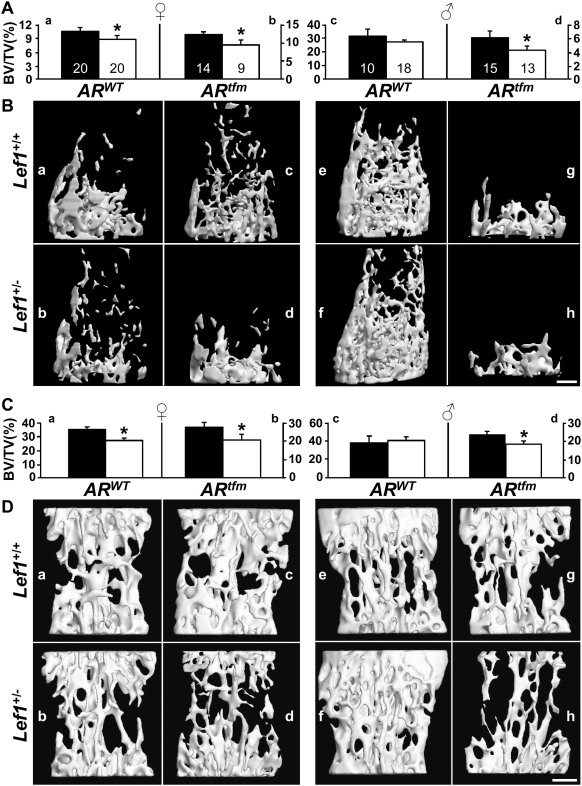
Androgen signaling protects against Lef1 haploinsufficiency-induced low bone mass.μCT analysis of the trabecular bone compartment in distal femora (A,B) and vertebral bodies (C,D) of 13-week old female (left) and male (right) Lef1
+/+
(black) and Lef1+/− (white) mice. ARtfm males have no functional AR, while ARtfm females are carriers for the defective AR allele. Data represent mean±SEM of 9–20 specimens as indicated within the bars at the top, * = p<0.05. (B) and (D) show respective μCT images of female (left) and male (right) mice with median BV/TV. Mice in a, b, e and f carry the wild-type AR (ARWT); mice in c, d, g and h carry the ARtfm allele; mice in a, c, e and g are Lef1
+/+; mice in b, d, f and h are Lef1
+/−. Scale bar = 0.5 mm.